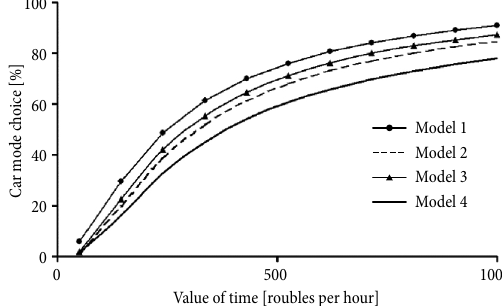
Fig. 7. Influence of fare at the public transport on characteristics of the Model 1